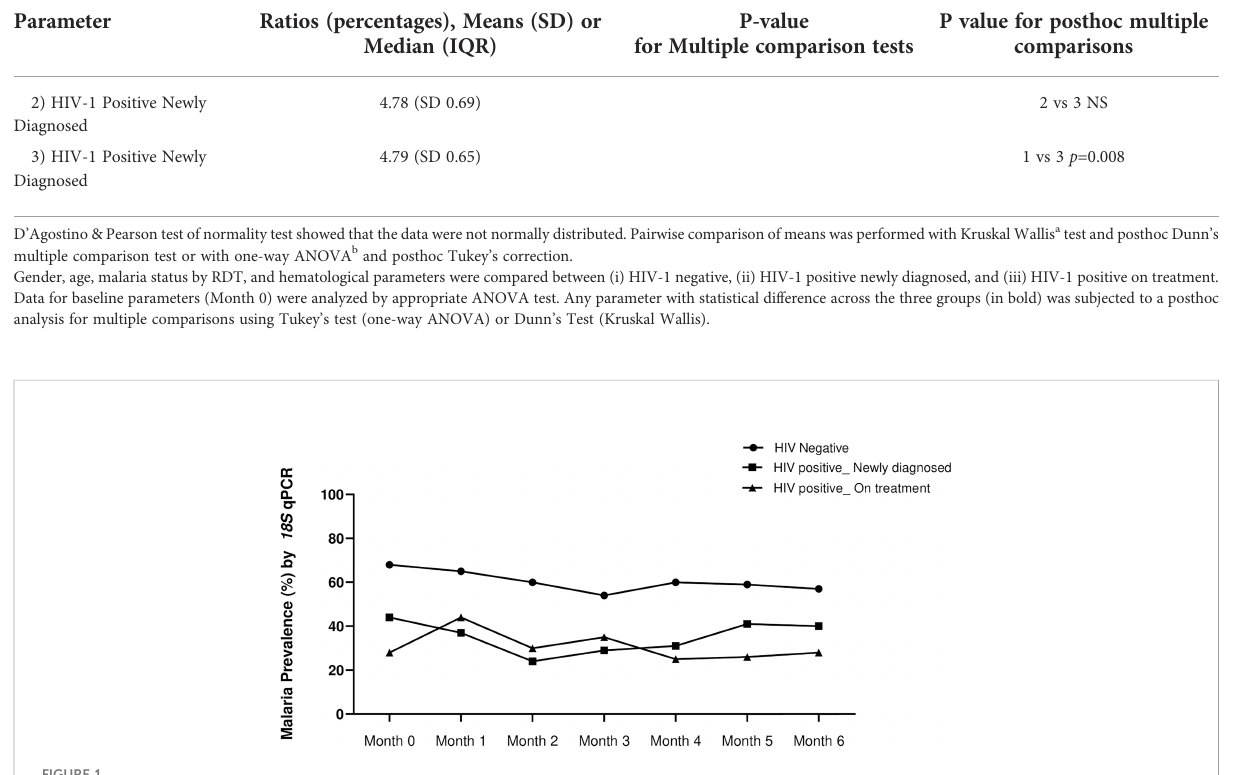
FIGURE 1 Temporal malaria positivity rate as determined by 18S genus qPCR assay at enrollment (month 0) and during 6 months follow up (months 1-6). Prevalence of asymptomatic parasitemia was highest in the HIV-1 negative volunteers (black circles) at all time-points ( p =0.0001, one way